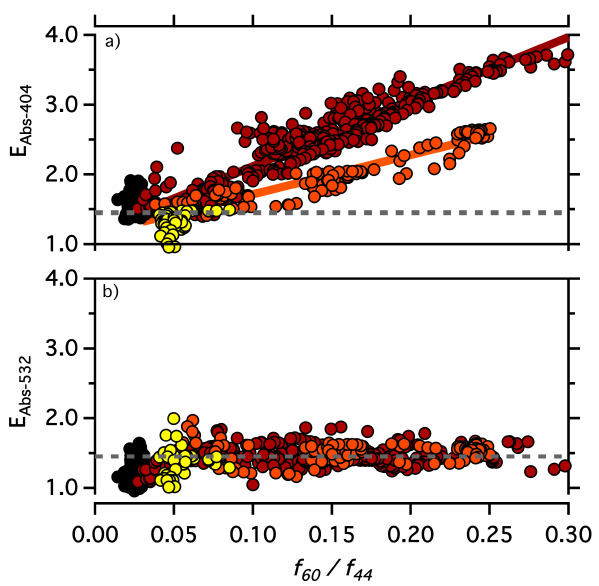
Fig. 2. Absorption enhancement relationship with f 60 / f 44 at (a) 404nm and (b) 532nm. The color-coding shows the different sam- pling periods of the BB plume. Horizontal dashed line indicates reasonable E Abs (1.5) expected from theory from internal mixing only (Bond et al., 2006). Linear fits for red and orange data periods shown in (a) . (red data: slope = 9.2 ± 0.2, R 2 = 0.93; orange data: slope = 5.6 ± 0.2, R 2 = 0.95).